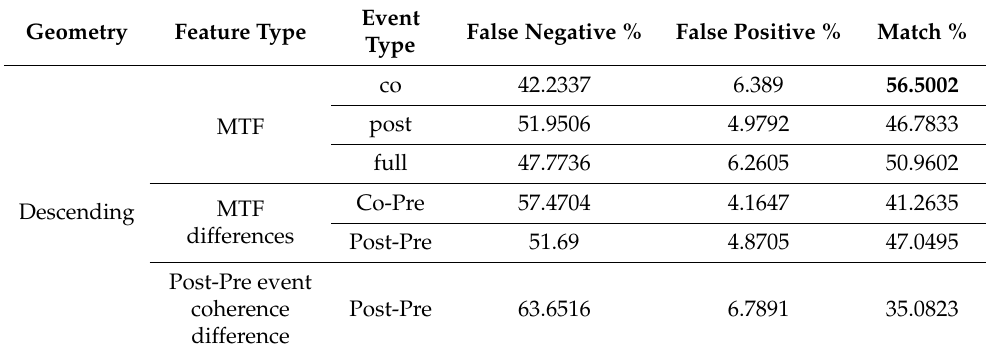
Table 3. Results of classification on descending geometry data. (The best match is marked in bold